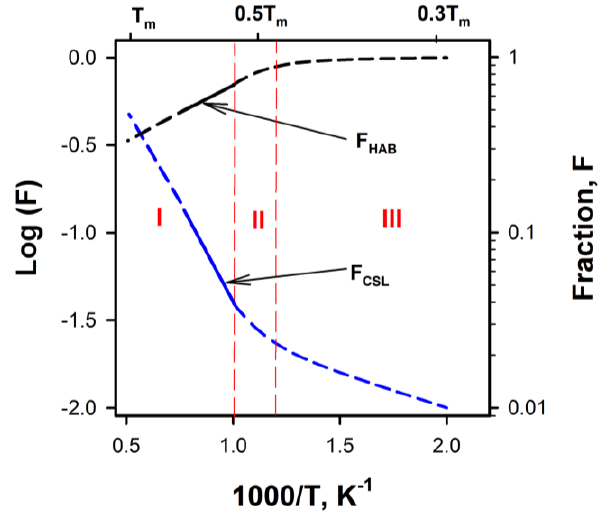
Figure 10. Variations of the fractions of HAB ( F HAB ) and CSL ( F CSL ) boundaries in austenitic stainless steels with deformation conditions.